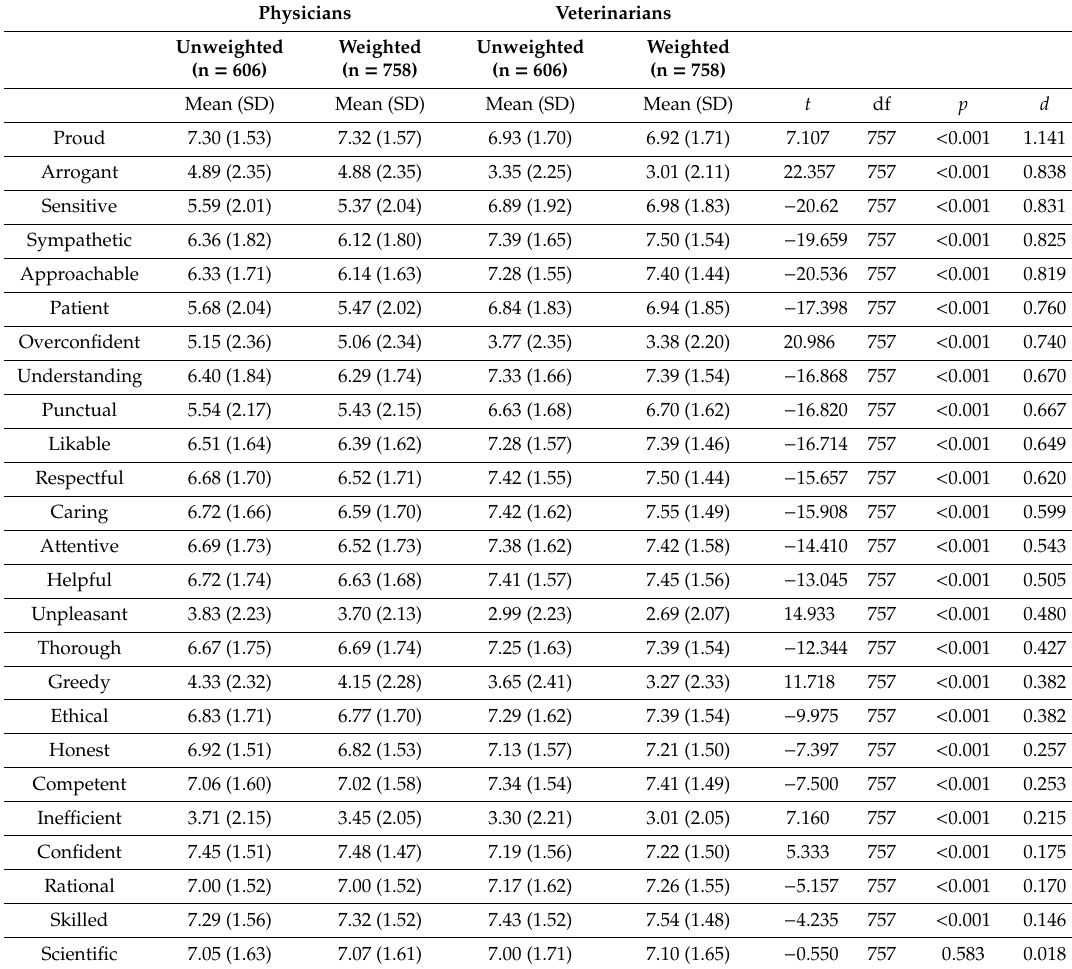
Table 2. Comparison of the ratings for physicians and